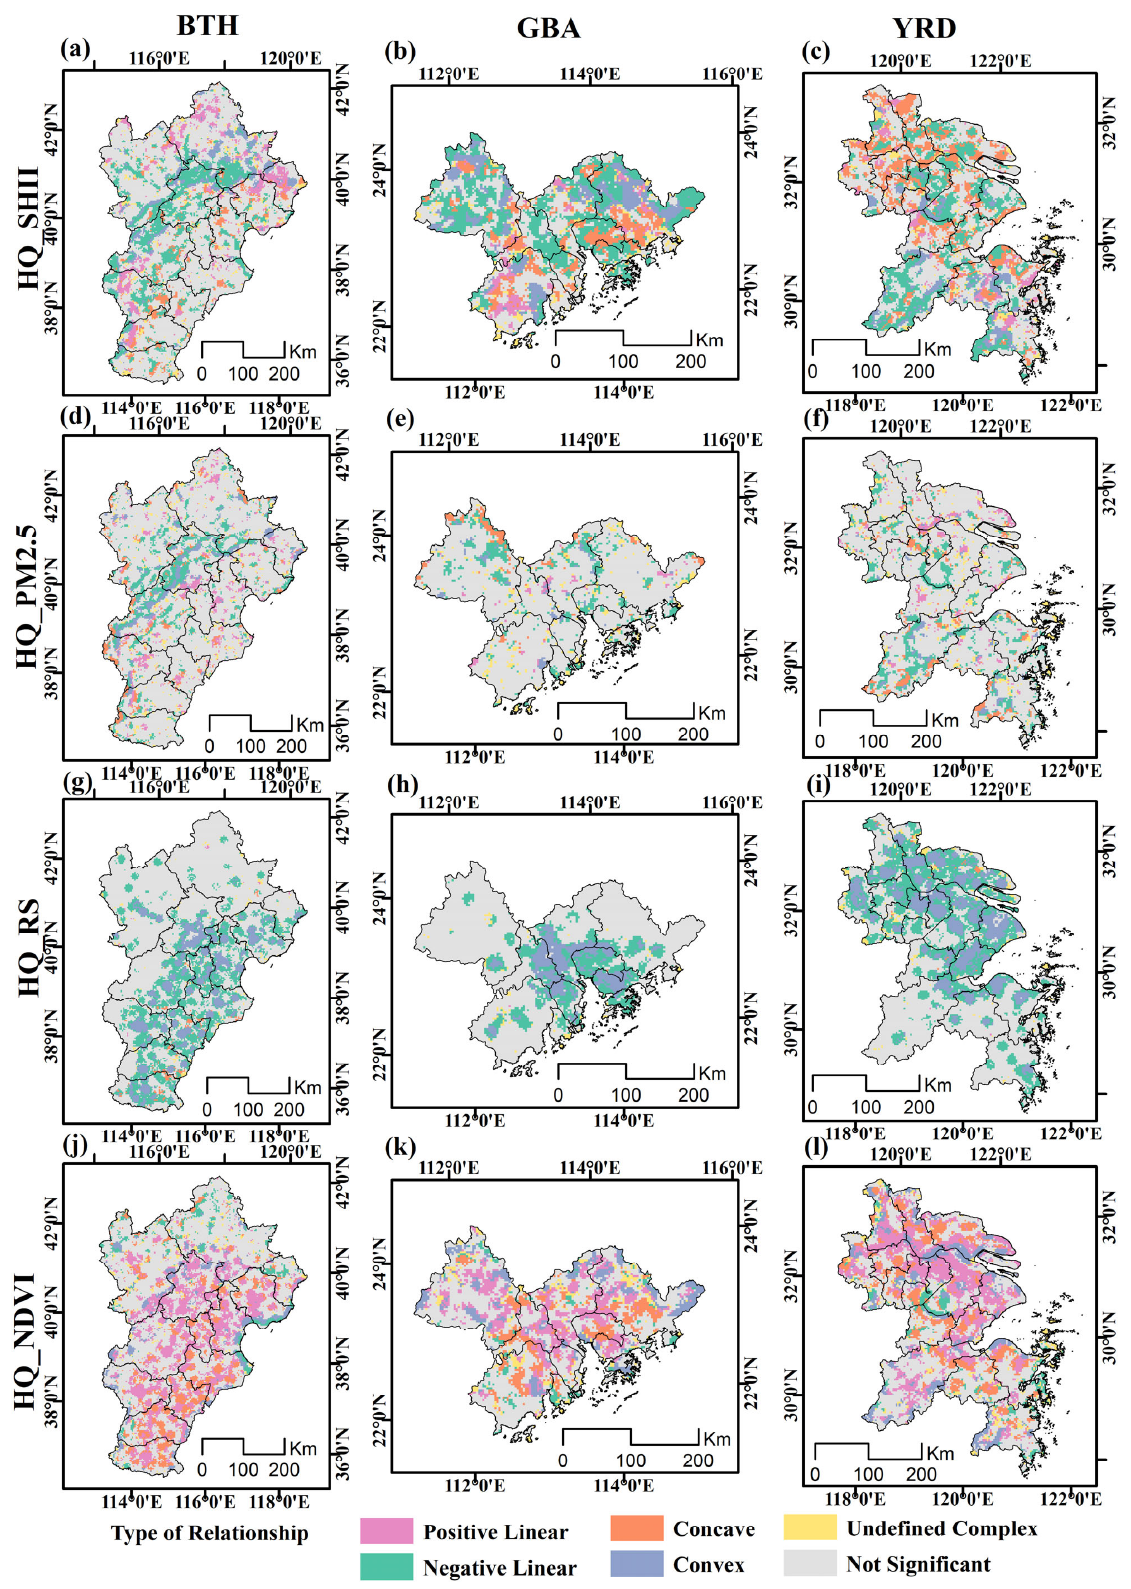
Figure 12. Local spatial relationship between habitat quality and multifaceted environmental states: ( a – c ) HQ–SHII for BTH, GBA, and YRD, respectively; ( d – f ) HQ–PM2.5 for BTH, GBA, and YRD, respectively; ( g – i ) HQ–RS for BTH, GBA, and YRD, respectively; and ( j – l ) HQ–NDVI for BTH, GBA, and YRD,